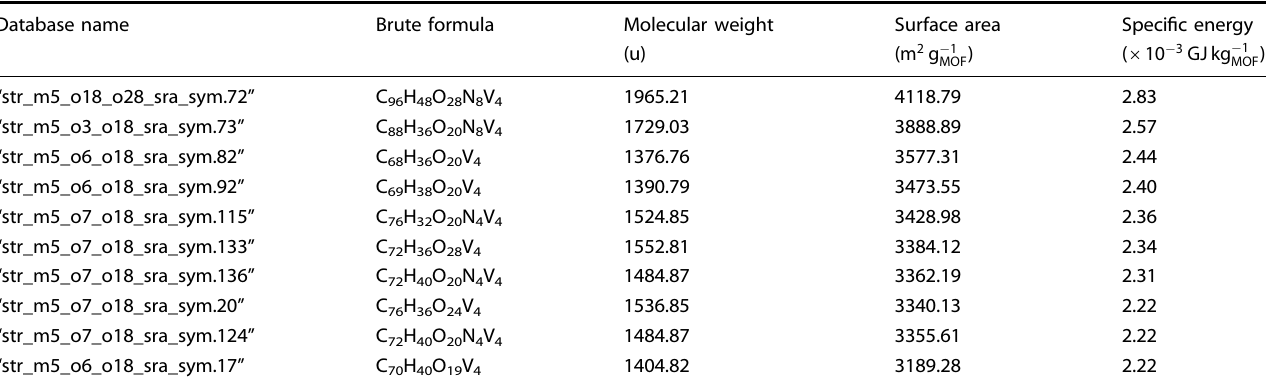
Fig. 7 Adsorption/desorption based thermal energy storage cycle for the potential MOF ‘ str_m5_o18_o28_sra_sym.72 ’ with water, in the coverage-pressure plane. The isotherms T A = 308 K and T C = 353 K are shown. Surface S , isosteric heat q st , and coverage span Δ θ over the cycle are reported, giving an objective function Sq st Δ θ ¼ g (cid:2) 1 1 : 32 ´ 10 5 kJm 2 mol (cid:2) 1 or equivalently 2 : 83 ´ 10 (cid:2) 3 GJkg (cid:2) 1 , H 2 O MOF MOF which corresponds to 1.73 GJm − 3 . Table 3. Top ten potential MOFs in terms of speci fi c energy from the database by Boyd et al. 46